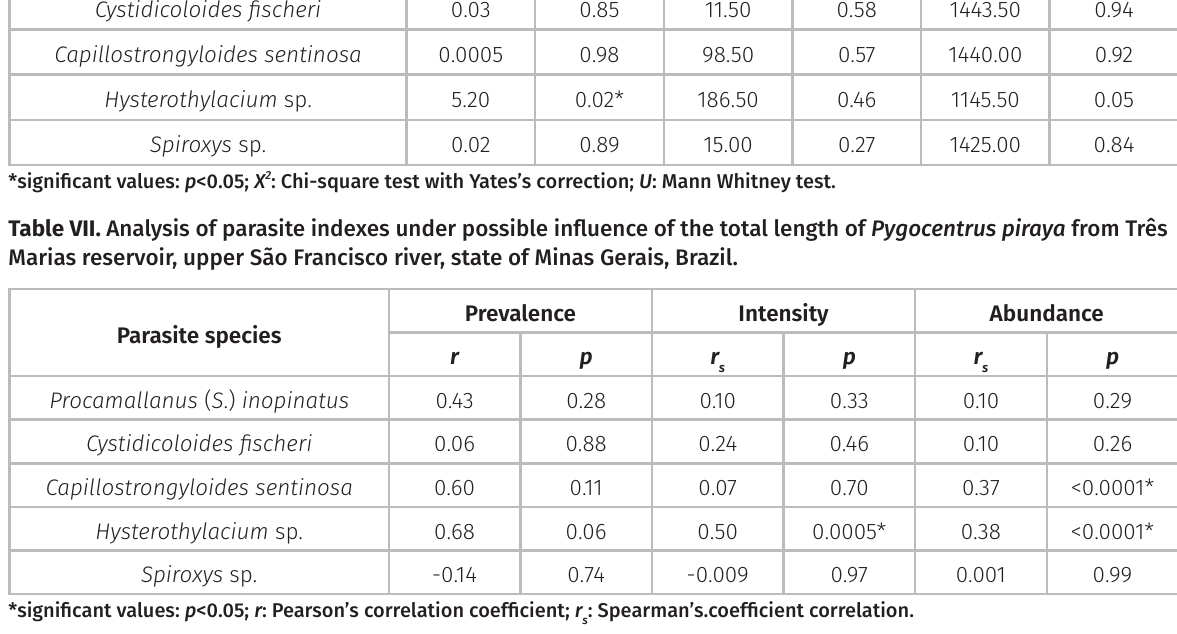
Table VI. Analysis of parasite indexes under possible influence of the sex of Pygocentrus piraya from Três Marias reservoir, upper São Francisco river, state of Minas Gerais, Brazil. Prevalence Parasite species Procamallanus ( S .) inopinatus